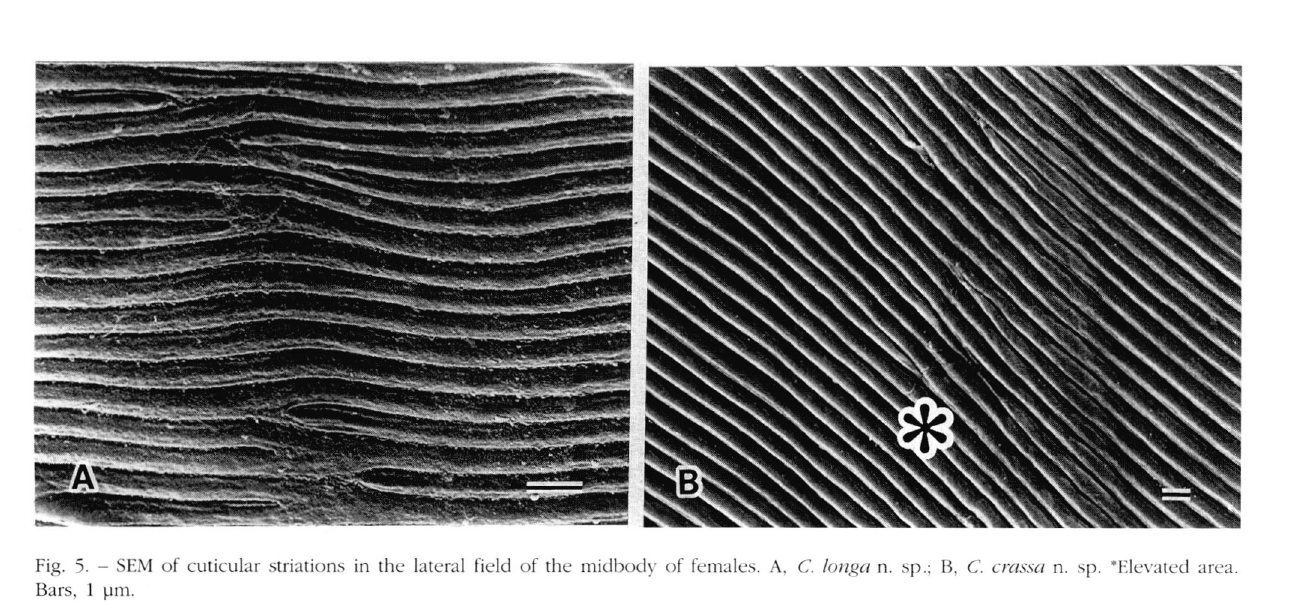
Fig. 5. - SF.M of cuticular striatums in the lateral field of the midbody of females. A, C. longa n. sp.; B, C. crassa n. sp. 'F.levated area. Bars, 1